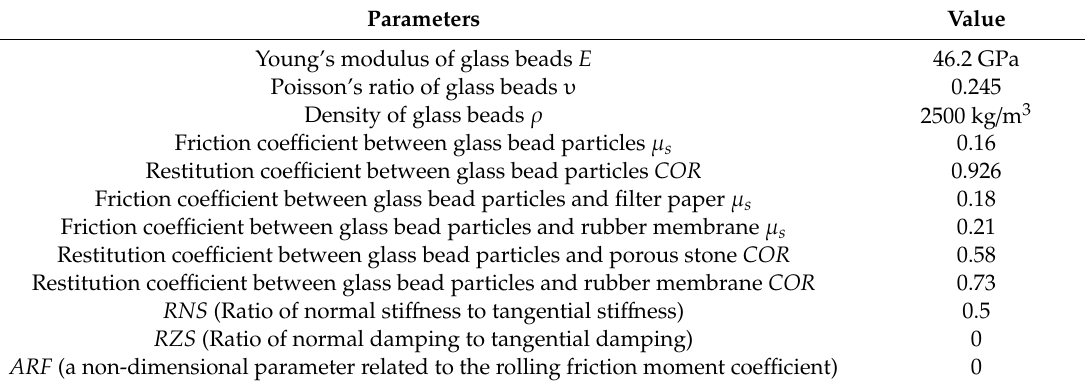
Table 5. The parameters for discrete element method